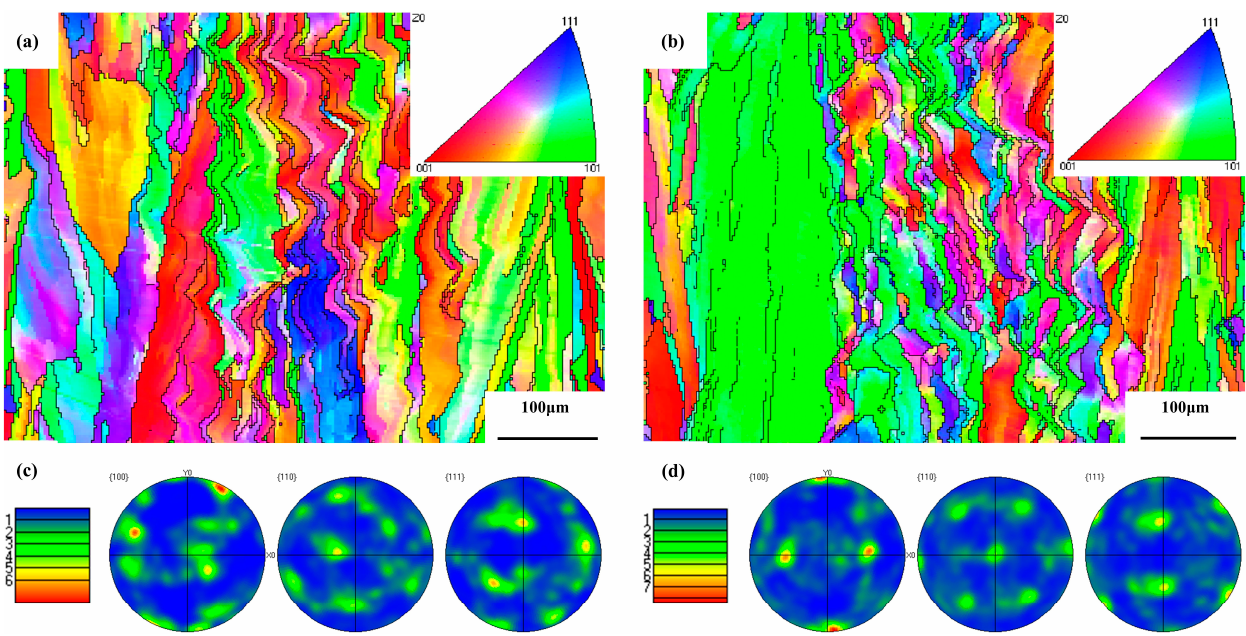
Figure 9. EBSD analysis of vertical sections of top ( a , c ) and bottom ( b , d ) of thin-wall cladding, ( c , d ) pole figure of ( a , b ).